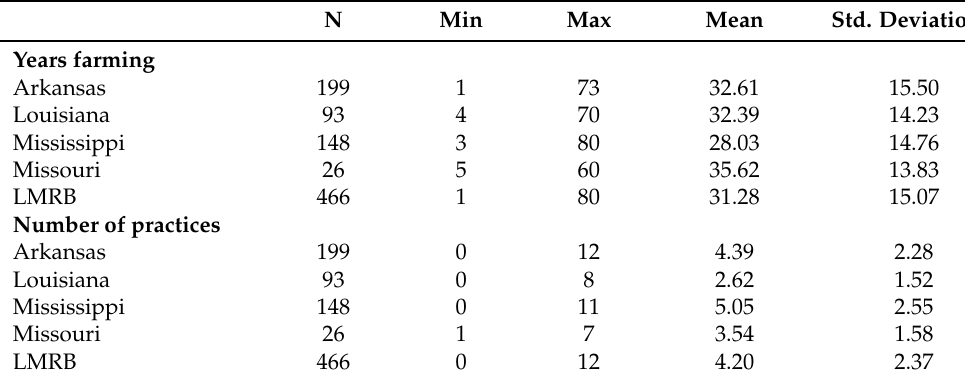
Table 2. Farmer experience across the Lower Mississippi River Basin